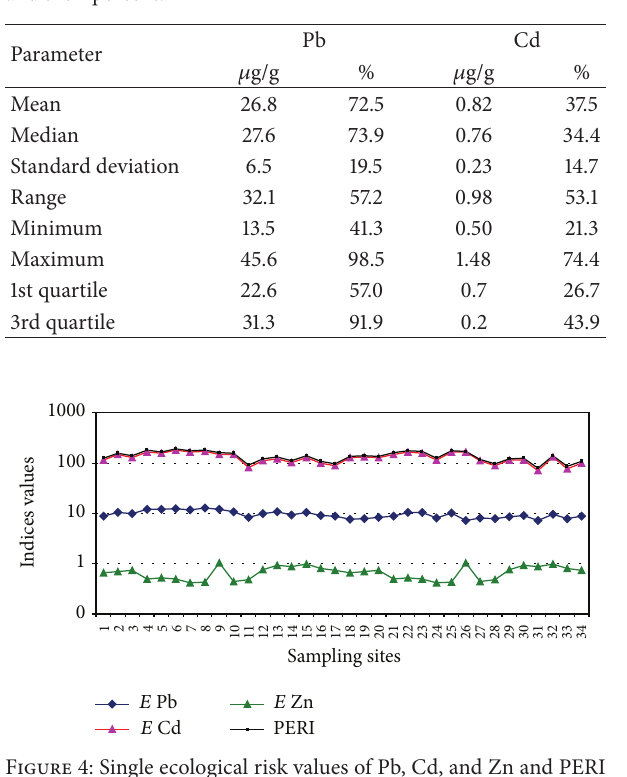
Table 4: Summary statistics of bioavailable fractions of Pb and Cd and their percent.